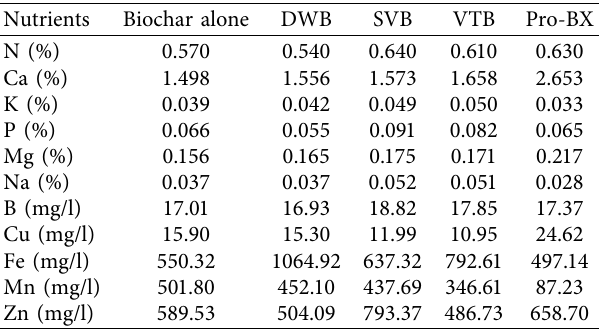
Table 2: Mineral nutrient composition of the growing media components.